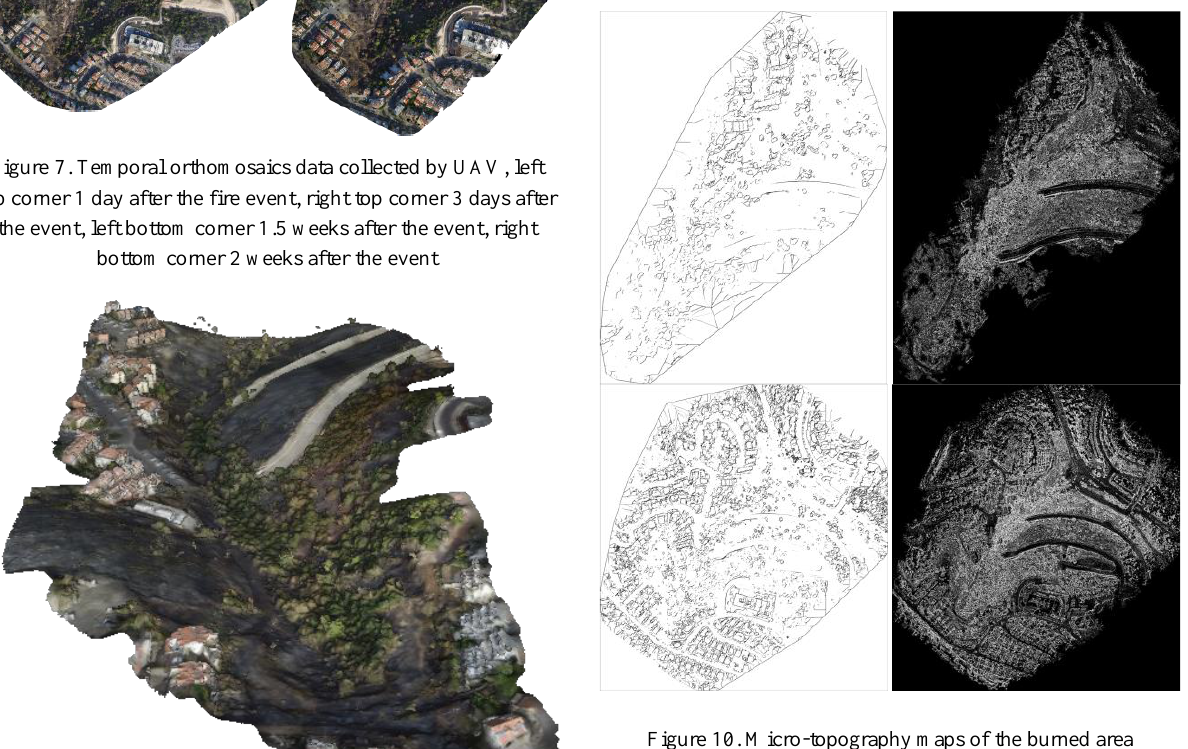
Figure 10. Micro-topography maps of the burned area calculated from the 3-D point cloud by the GLCM algorithms – homogeneity products are presented in left top corner 1 day after the event, left bottom corner 3 days after the event; entropy pruducts are presented in right corner